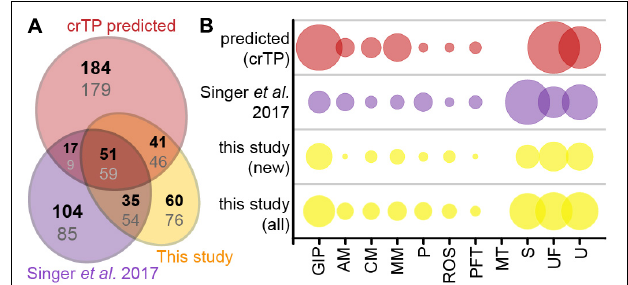
FIGURE 5 | Newly identified import candidates . (A) Numbers of newly identified import candidates in this study (see Figure 3A , yellow), previously MS-identified import candidates (Singer et al., 2017, purple), and in silico predicted import candidates (Singer et al., 2017, red). Numbers in bold indicate distribution of proteins considering only HC import candidates, numbers in gray considering all import candidates. (B) Functional categories of import candidates in (A) . GIP, genetic information processing; AM, amino acid metabolism; CM, carbohydrate metabolism; MM, miscellaneous metabolism; P, photosynthesis and light protection; ROS, response to oxidative stress; PFT, protein folding and transport; MT, metabolite transport; S, short proteins ( < 90 aa) without functional annotation/homologs; UF, unspecific function; U, unknown function. “New” import candidates were MS-identified in this study, but not in Singer et al.